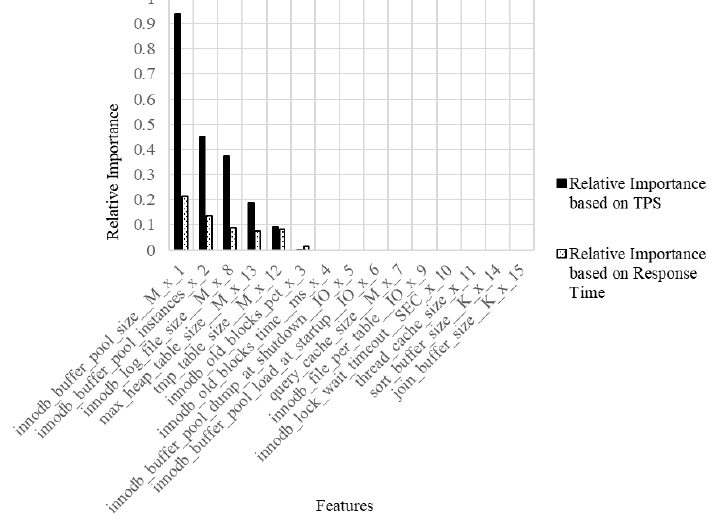
Figure 5. Relative importance of features according to Monte Carlo Feature Selection (MCFS).